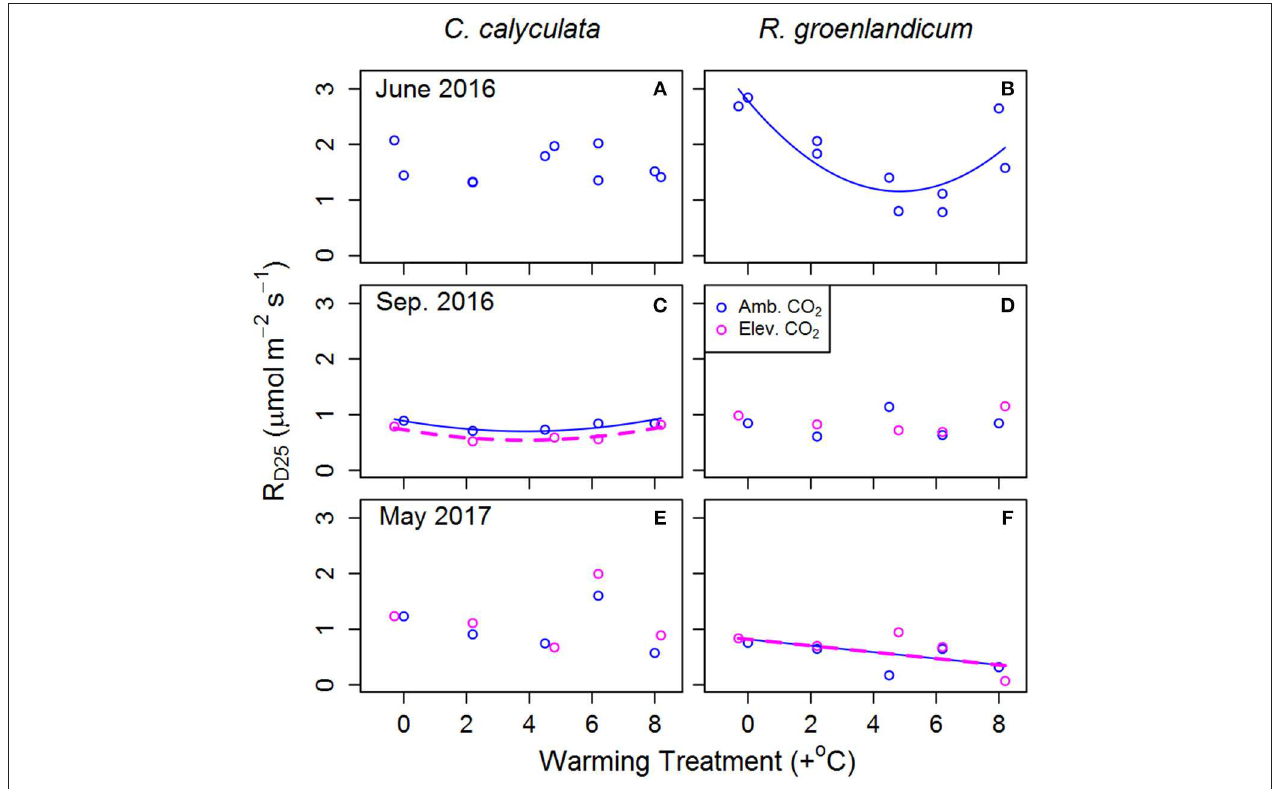
FIGURE 1 | Mean dark-acclimated respiration per unit leaf area at 25 ◦ C ( R D 25 ) for two shrub species at the SPRUCE site, for newly expanded ( A,B ; June 2016), mature ( C,D ; September 2016), and overwintered ( E,F ; May 2017) leaves in each plot. Warming treatments indicate growing season (April–October) mean daytime temperature difference from the control plot and color indicates ambient (400 ppm) or elevated (900 ppm) [CO 2 ] treatments. Lines indicate fit of best model, as evaluated using Akaike Information Criterion corrected for sample size (AICc). Panels without lines have intercept-only best models as shown in Table 1